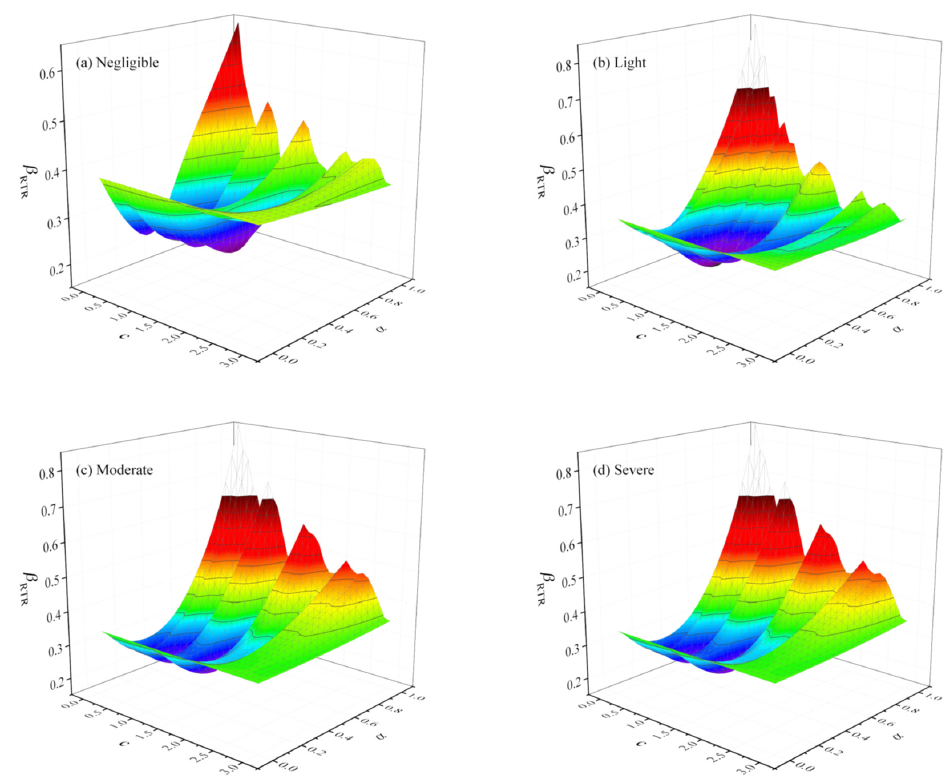
Figure 12. β RTR obtained using IM ∗ with different values of c and α under far-field earthquakes.